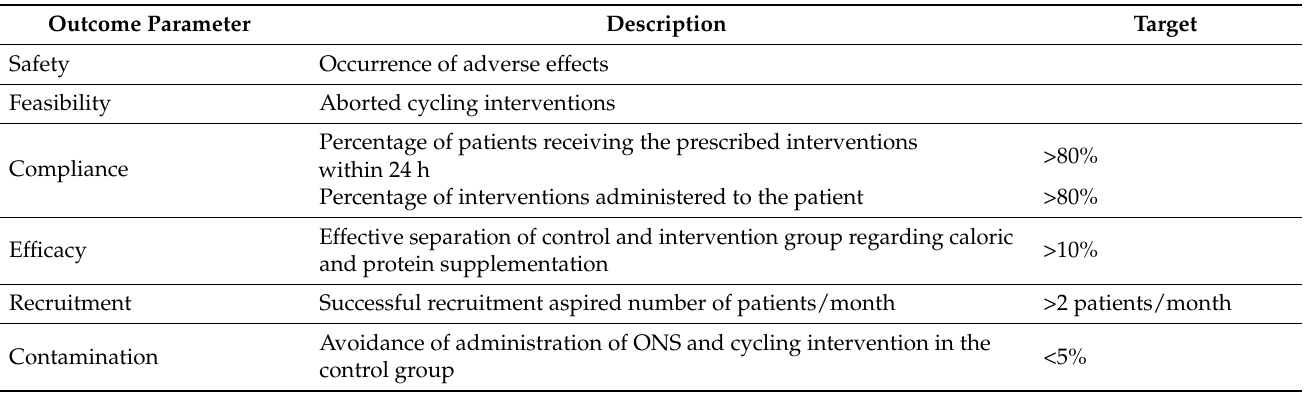
Table 4. Primary outcome parameters. Abbreviations: ONS: oral nutrition